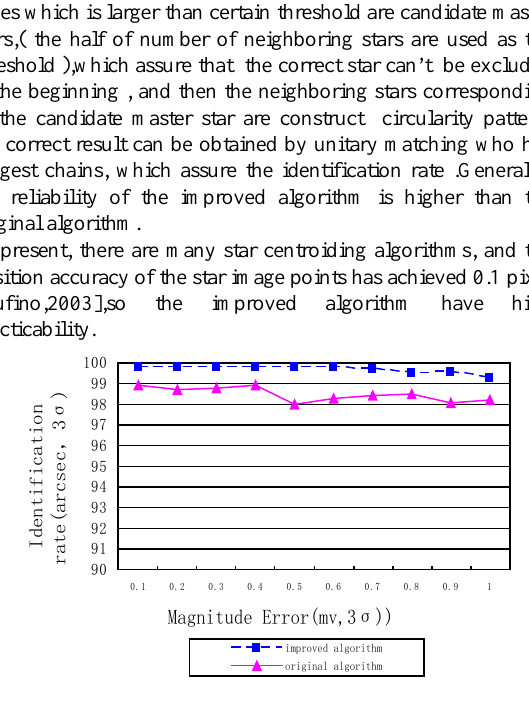
Figure.5. Success identification rates comparability under certain magnitude error and random position error.